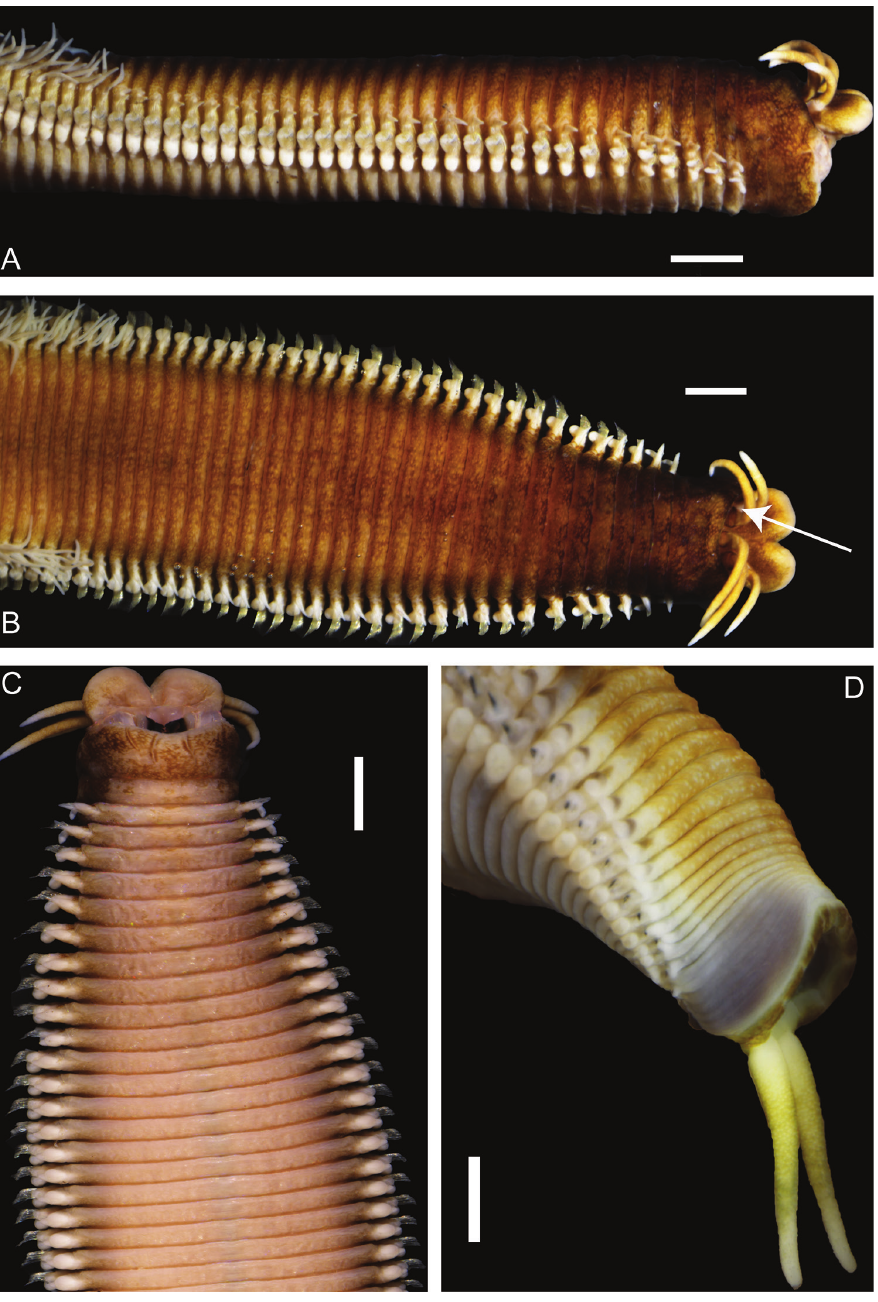
Figure 2. Marphysa victori sp. n.: A Anterior part, lateral view (paratype MNHN-IA-TYPE 1807) B Anterior part, dorsal view (paratype MNHN-IA-TYPE 1807) C Anterior part, ventral view (paratype MNHN-IA-TYPE 1807) D Pygidium, lateral view (paratype MNHN-IA-TYPE 1803). White arrow showing eye. Scale bars: 2 mm ( A, B, C ), 1 mm ( D